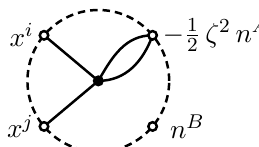
(cid:16) 2 n A . There is a similar diagram 2